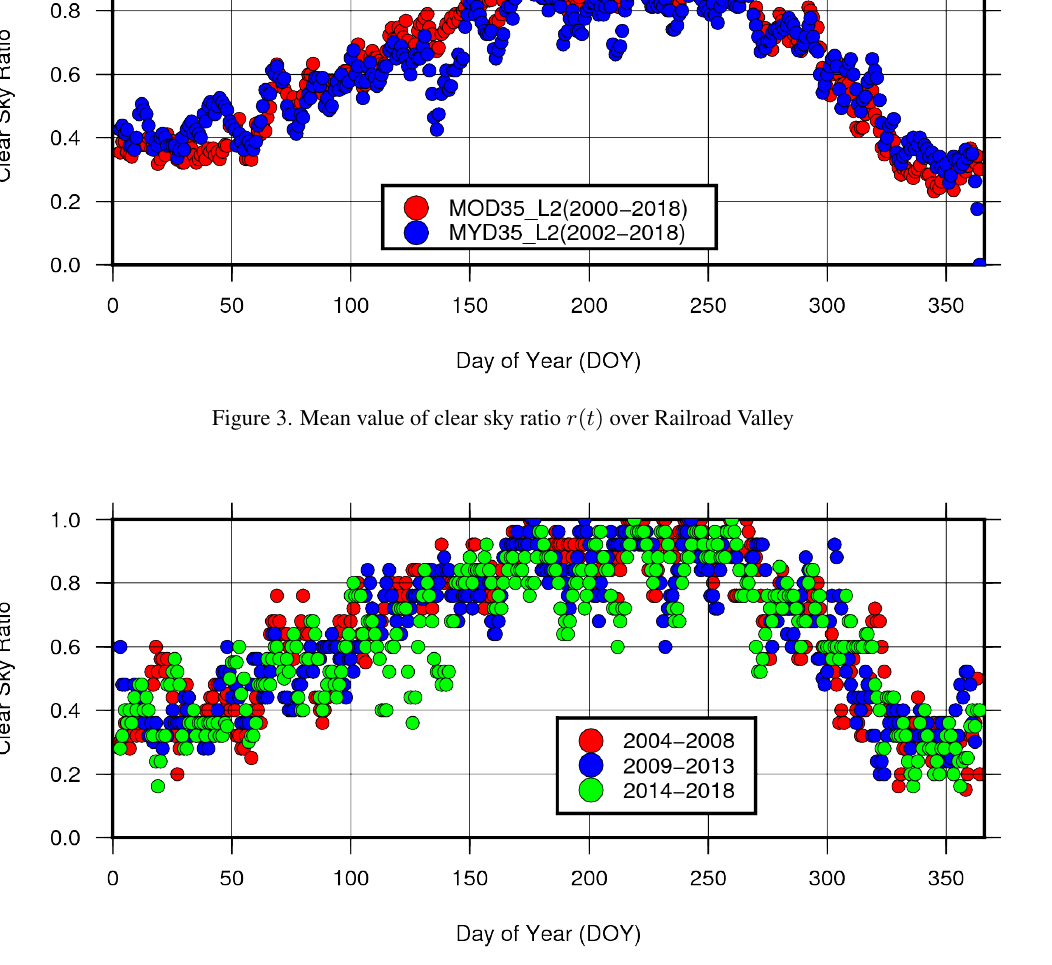
Figure 4. Mean value for a five year period of clear sky ratio r ( t ) over Railroad Valley (MOD35 L2)